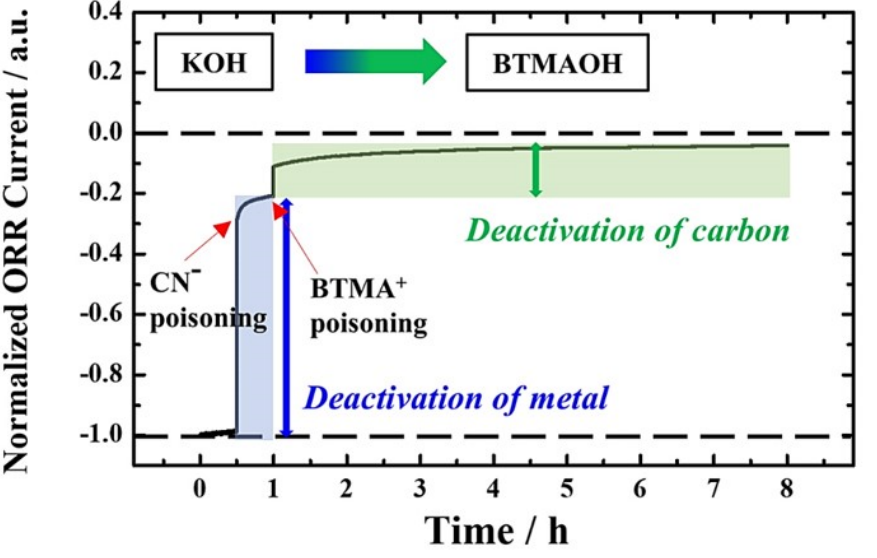
Figure 5. Chronoamperogram of Pt/C at 0.7 V sequentially measured in O 2 − saturated 0.1 M KOH for 30 min, in O 2 − saturated 0.01 M KCN − mixed 0.1 M KOH for 30 min, and in O 2 − saturated 0.1 M BTMAOH for 7 h. When changing the electrolyte to BTMAOH in the last step, the GC was washed several times with DI water to completely remove non − poisoned CN - .